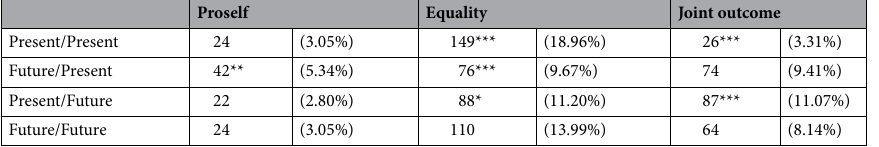
Table 1. The number of participants with each social value orientation in each condition. ***: Bonferroni- corrected p < .001; **: Bonferroni-corrected p < .010; *: Bonferroni-corrected p <